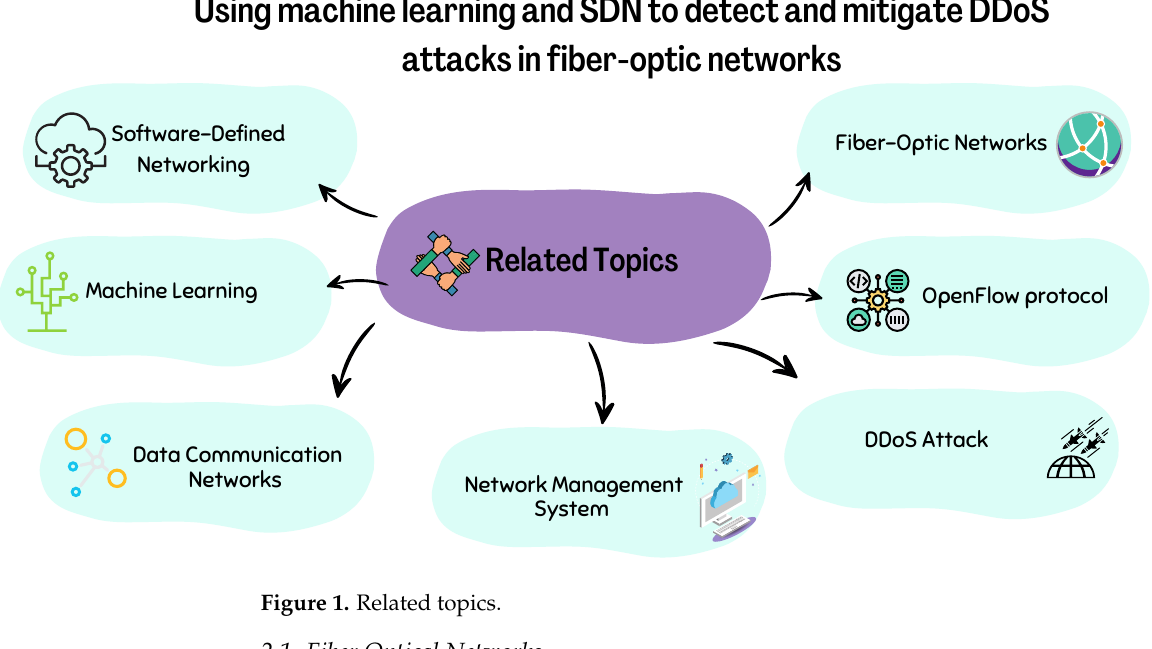
Figure 1. Related